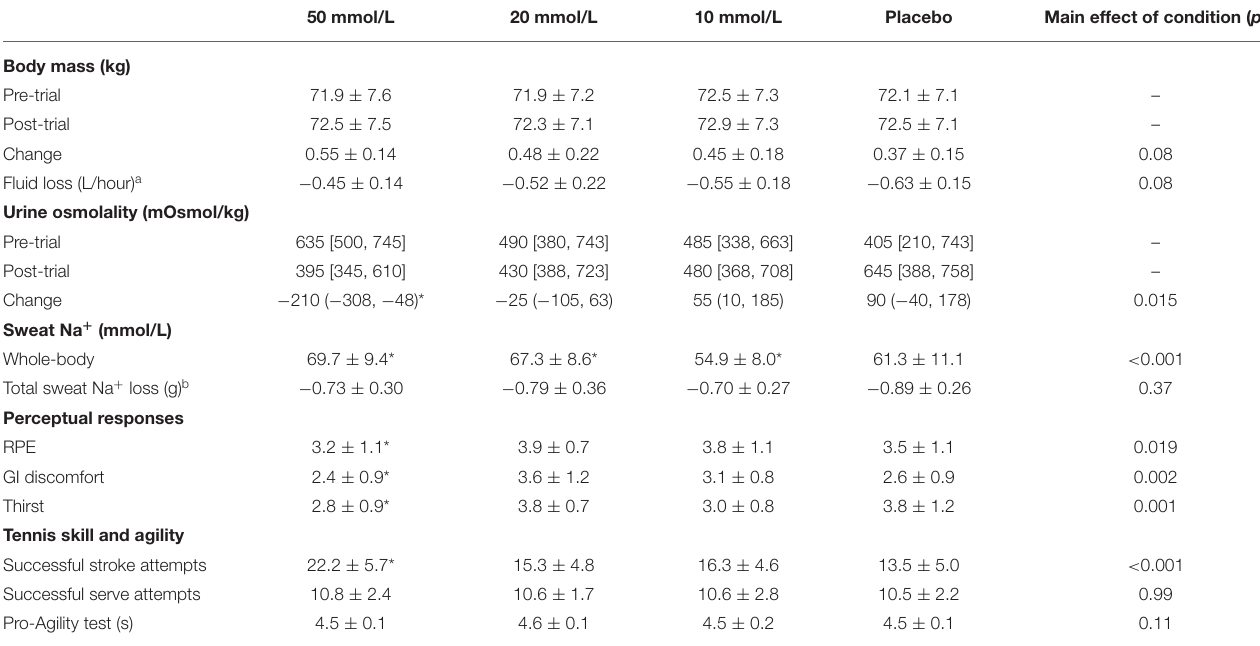
TABLE 1 | Descriptive statistics of outcomes in each experimental condition (mean ± SD or median